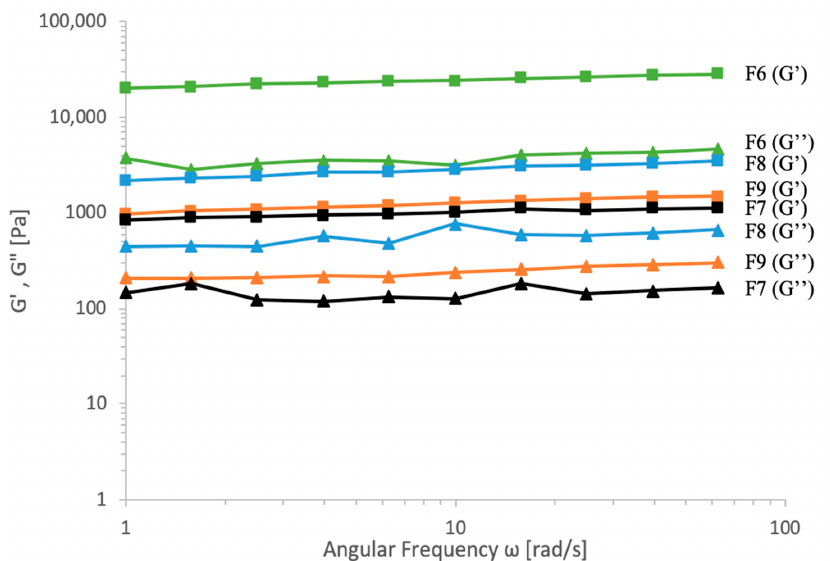
Figure 7. Determination of storage modulus, G’ (square symbol), and loss modulus, G” (triangle symbol), of four gelled formulations; F6: [4% CNC: 4% Alg: 10% PEGDA]; F7: [4% Alg: 40% PEGDA]; F8: [4% CNC: 4% Alg: 40% PEGDA]; and F9: [2% CNC:2.5% Alg:25% PEGDA].